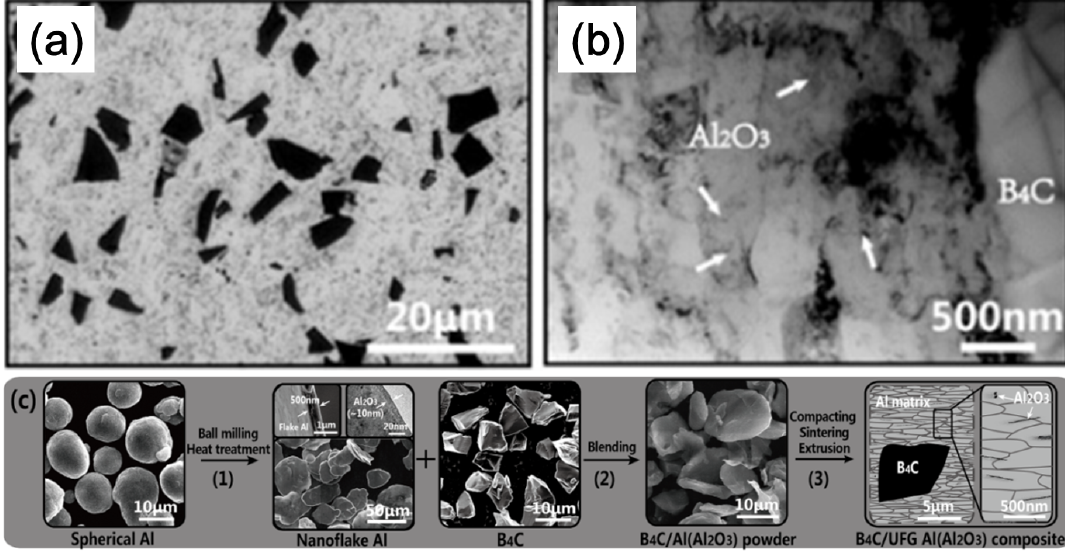
Figure 4: (a) SEM images of the B 4 C/UFG Al(Al 2 O 3 ) nanocomposite showing the uniformly distributed micron-sized B4C particles, (b) TEM images of the B C/UFG Al(Al O ) nanocomposite. The white arrows indicate the embedded Al 4 2 3 route of the Flake PM